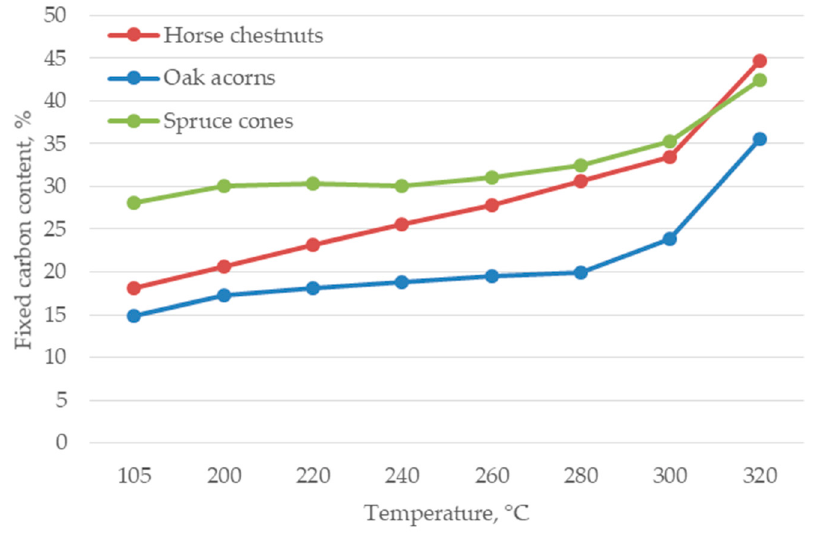
Figure 8. Fixed carbon content in the torrefied horse chestnuts, oak acorns, and spruce cones.